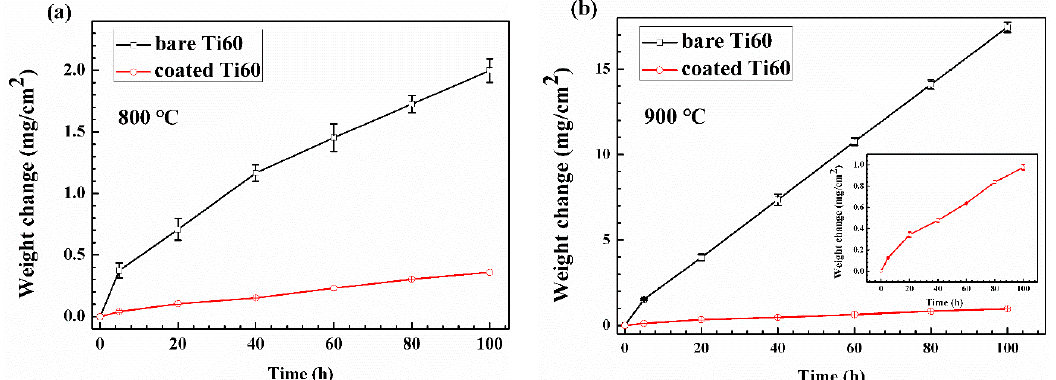
Figure 2. Mass change curve during oxidation at ( a ) 800 ◦ C and ( b ) 900 ◦ C.